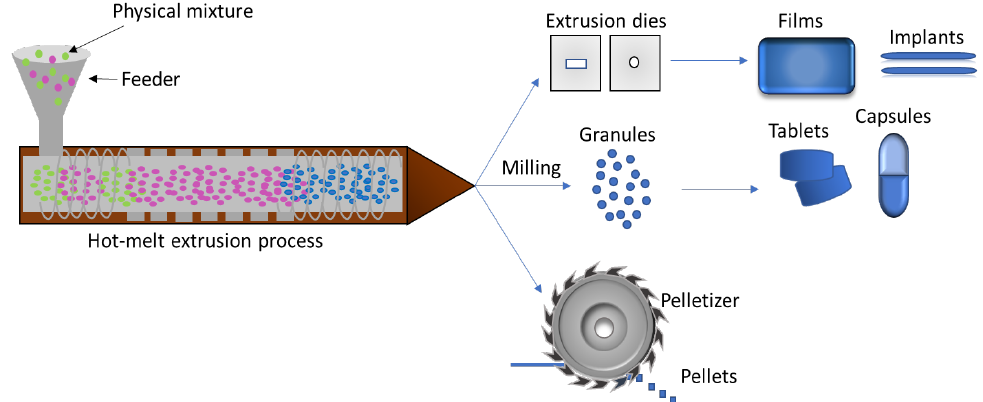
Figure 11. Schematic of hot-melt extrusion of films, tablets, capsules, and pellets (adapted from [178]).